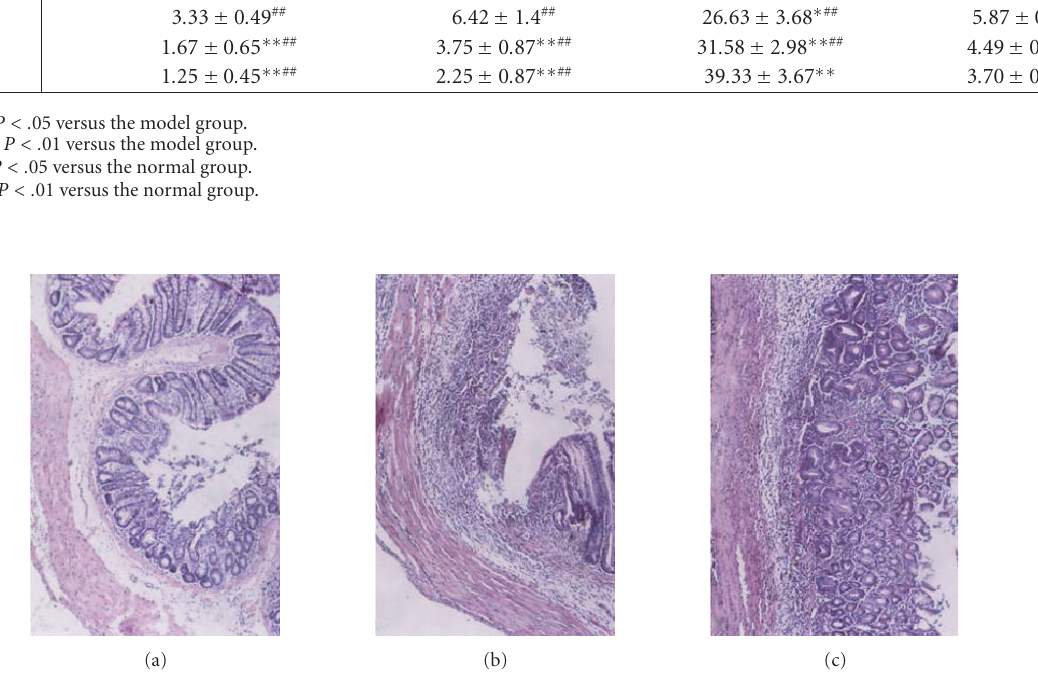
Figure 1: The haematoxylin and eosin staining of colon tissues: (a) no damage in N group (H&E, group, the colonic mucosa showed necrotic destruction of epithelium, hemorrhage, edema, inflammatory cellular infiltration and ulceration 100); (c) the changes of histology with HD EGB (200 mg/kg) group (H&E, at mucous and submucous layers (H&E, (cid:2)